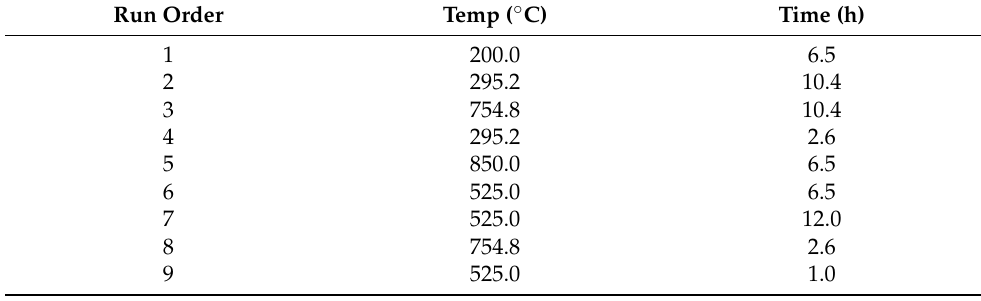
Table 2. DOE for silt calcination under different times and temperatures.